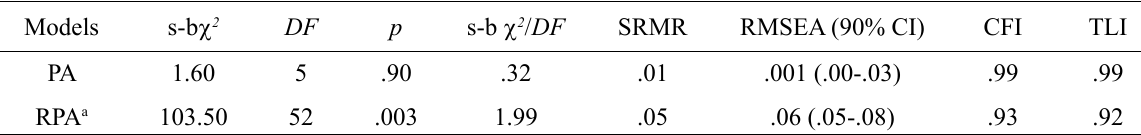
Con fi rmatory Factor Analyses of PARB-Q: Goodness-Of-Fit Indexes Models